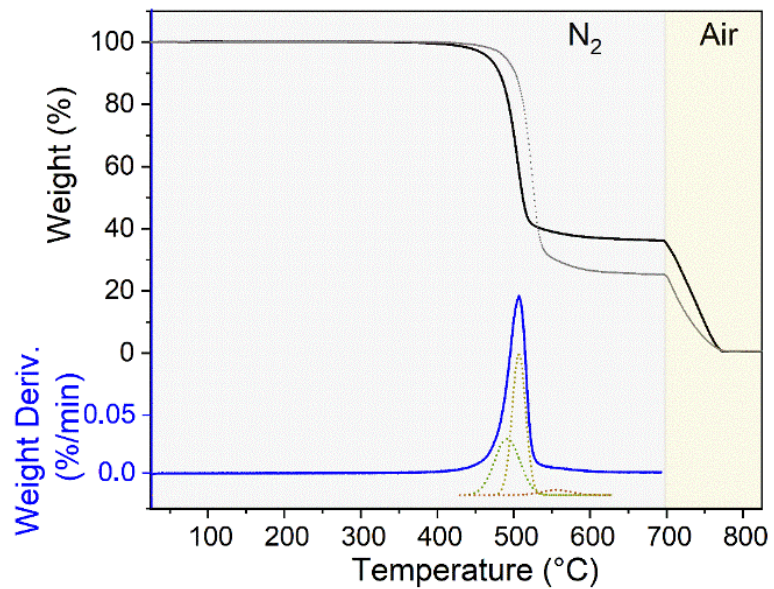
Figure 1. TGA curves of neat PC (gray dotted curve) and of PC + CB 16 wt.% (black line) during the thermal treatment in N 2 (from room temperature to 700 °C) and in air (from 700 to 850 °C). The weight derivative of PC is also shown (blue curve) together with its deconvolution into three separated signals.